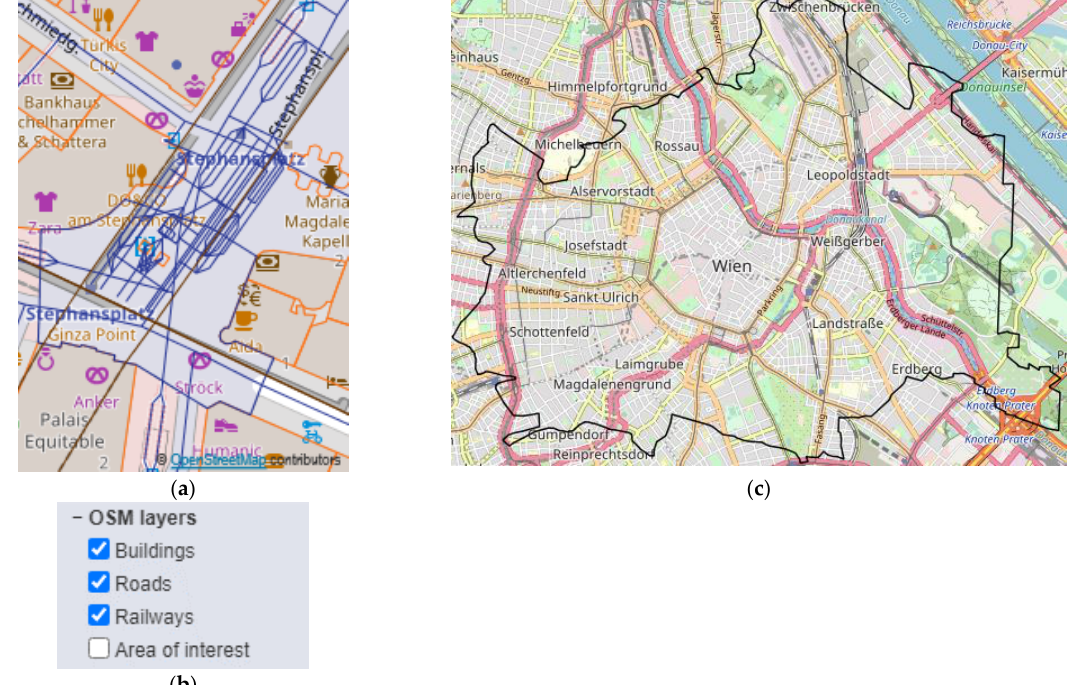
Figure 13. OSM data for buildings, roads, and railways ( a ) are portrayed at the user’s choice ( b ) to help data understanding. The area of the city covered in the case study can be portrayed as well ( c ) (Vienna). The web application was built using both client-side and server-side tools for the publishing and portrayal of geographic data. Client-side tools are advantageous in terms of interactivity. The GeoJSON format for data encoding and the Leaflet library were uti- lized. Server-side tools are appropriate for large datasets and require a geographic data server (e.g., Geoserver). Regarding VGI quality symbolization, the Leaflet library was con- sidered sufficient for GeoJSON symbolization. A Styled Layer Descriptor (SLD) was uti- lized for data published as a WMS service from Geoserver. The HTML and CSS languages were used to format and display the content of the web mapping application. JavaScript was used to enhance the functionality of the application. Additional screenshots of the web map application can be found in Appendix B. 5. Discussion, Conclusions, and Future Work Although a variety of indicators and measures have been proposed in the past, the evaluation of VGI quality is still an open research topic. It is evident that visualization of VGI quality is of equal importance, as it works as an awareness tool for the novice user and an exploration tool for the expert. Consistency is an easily observed VGI quality ele- ment, and intrinsic assessment measures have been proposed. This research addresses consistency assessment based on topo-semantic constraints and visualization, along with an extensive case study.